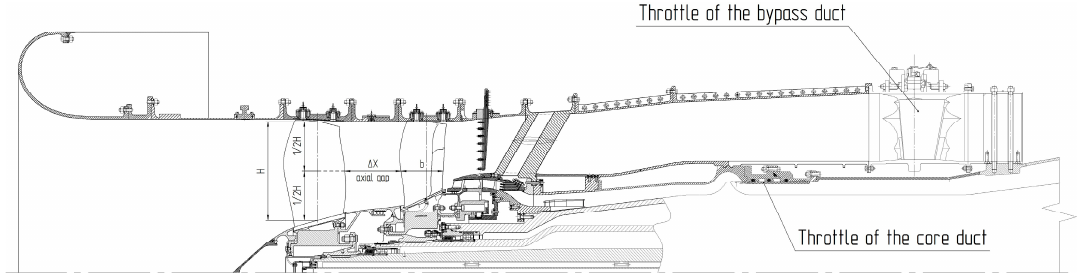
Figure 8. Counter rotating ducted CRTF1 model fan with solid titanium blades. Longitudinal section.